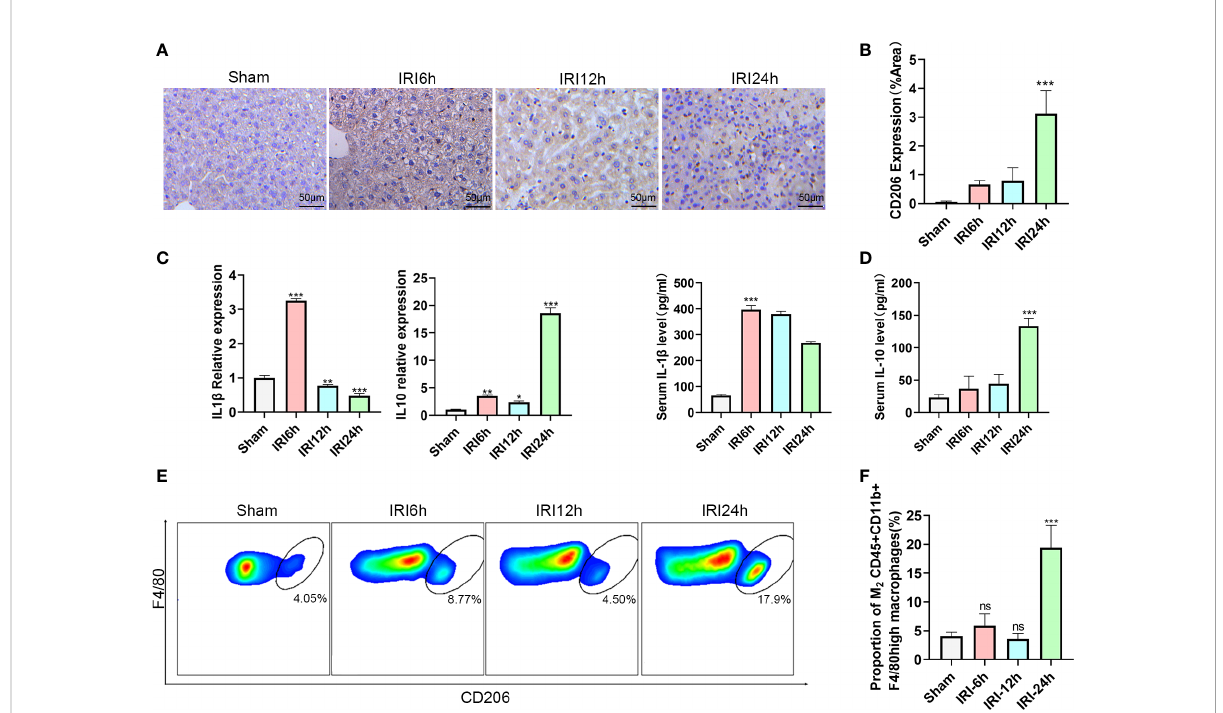
FIGURE 2 Proportion of M2 CD45+CD11b+F4/80high macrophages varies as a function of hepatic IRI stage. (A) Immunohistochemistry assay results demonstrating the changes in CD206 as a function of IRI time. (B) Semi-quanti fi cation of CD206 expression. (C) Relative gene expressions of IL-1 b and IL-10 in macrophages puri fi ed from mice liver at 6,12 or 24 h post-IRI and sham controls. (D) Serum IL-1 b and IL-10 levels in Sham and IRI groups at different post-reperfusion time periods. (E) Representative FACS analysis showing the percent of M2 CD45+ CD11b+ F4/ 80high macrophages in sham, IRI6h, IRI12h, IRI24h. (An CD206+ increase in proportion was assumed as a M2 polarization among CD45+CD11b + F4/80high cells) (F) Histograms of the percent of M2 CD45+CD11b+F4/80high macrophages (n = 5 per group). (ns P >0.05, * P <0.05,** P <0.01, *** P <0.001 versus